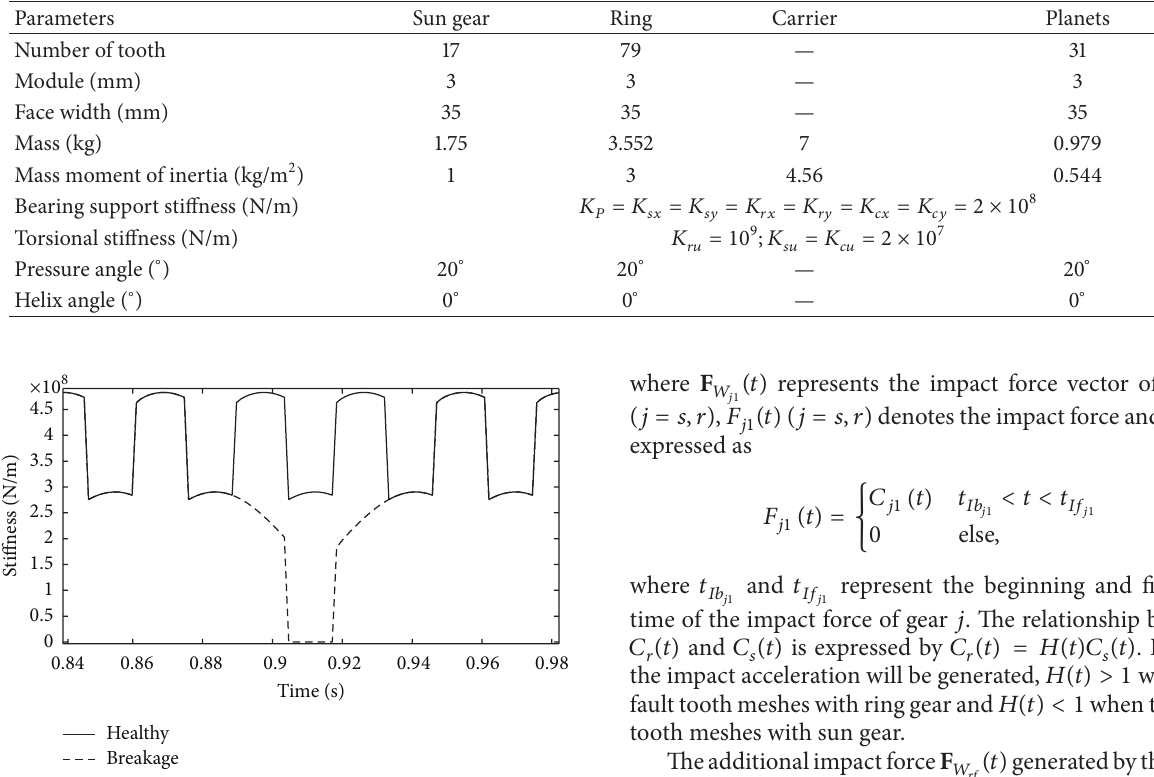
Table 1: Parameters of the planetary gear system.